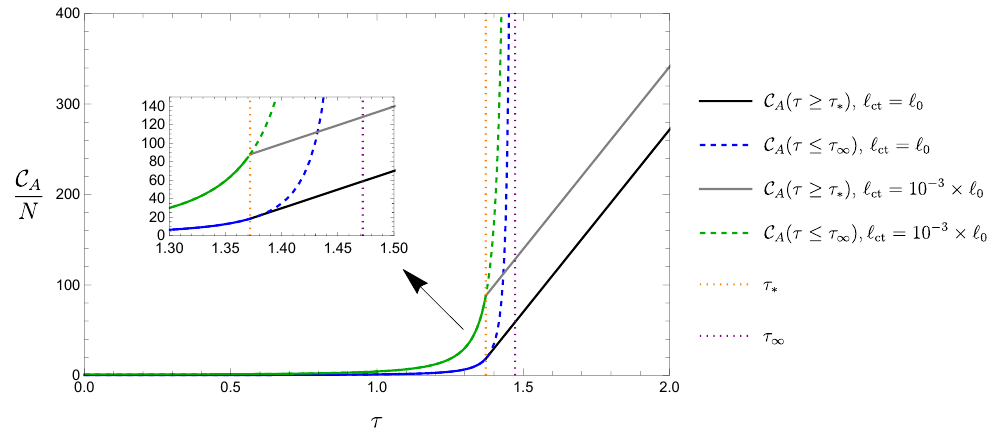
Figure 8 . The holographic complexity C plotted against the boundary time for two choices of A ‘ ct . The dashed lines show the unregulated divergent behaviour for τ < τ ∞ . The solid black and gray curves show the corresponding evolutions after the introduction of the cutoff surface. Note the linear growth for τ ≥ τ ∗ . For the choice ‘ ct = ‘ 0 , the regulated curve is continuous in the first derivative at τ = τ ∗ — see eq. (4.28). The typical non-smooth evolution of the regulated complexity is shown for the arbitrarily chosen value ‘ ct = 10 − 3 × ‘ 0 . Here we choose d = 3 , ρ = 9 and ε = 1 10 10